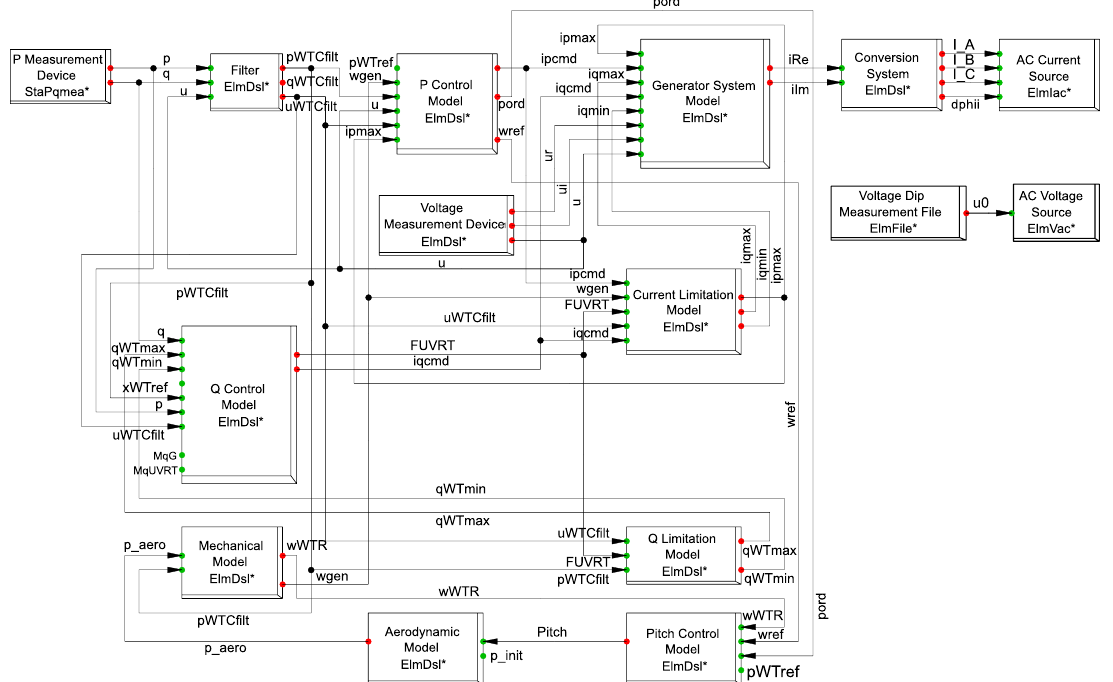
Figure 7. General structure of the IEC 61400-27-1 generic Type 3 model implemented in